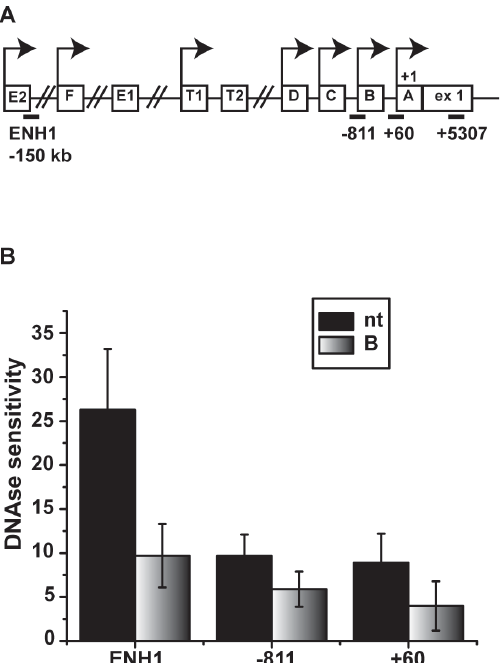
Figure 2. DNase sensitivity is reduced in the ESR1 enhancer region with proteasome inhibition. A ) Schematic of ESR1 promoter structure depicting the location of primers used for detecting DNase sensitivity and ChIP analysis B) Nuclei were isolated from MCF7 cells treated for 24 hours with vehicle or 30 nM bortezomib. Isolated nuclei were either left undigested or digested with DNase for 5 minutes, followed by incubation with Proteinase K to stop the DNase reaction, as described in Materials and Methods. DNA was purified and q-PCR was performed with primers to the indicated regions. Data are shown as the 2 ‘ (Ct cut–Ct uncut) and presented as mean 6 SEM. Statistical analysis was performed using a Student’s t-test. No statistically significant differenc- es were observed (p .